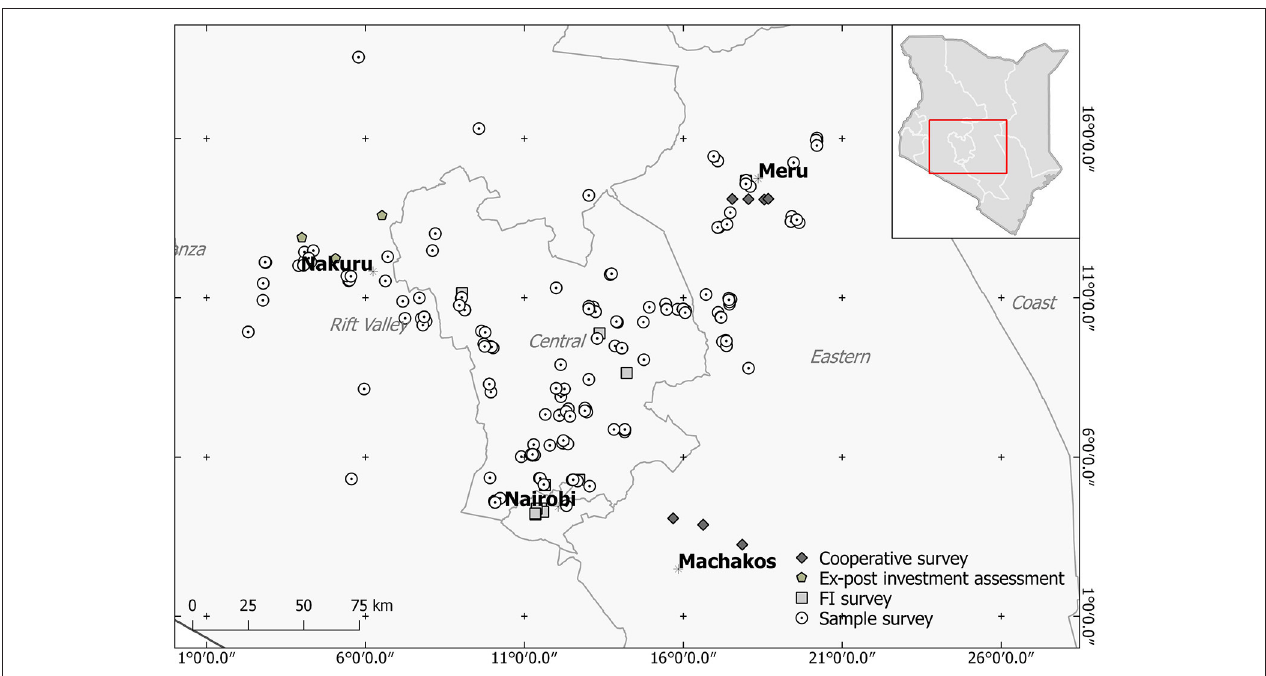
FIGURE 1 | Location of survey sites in Central